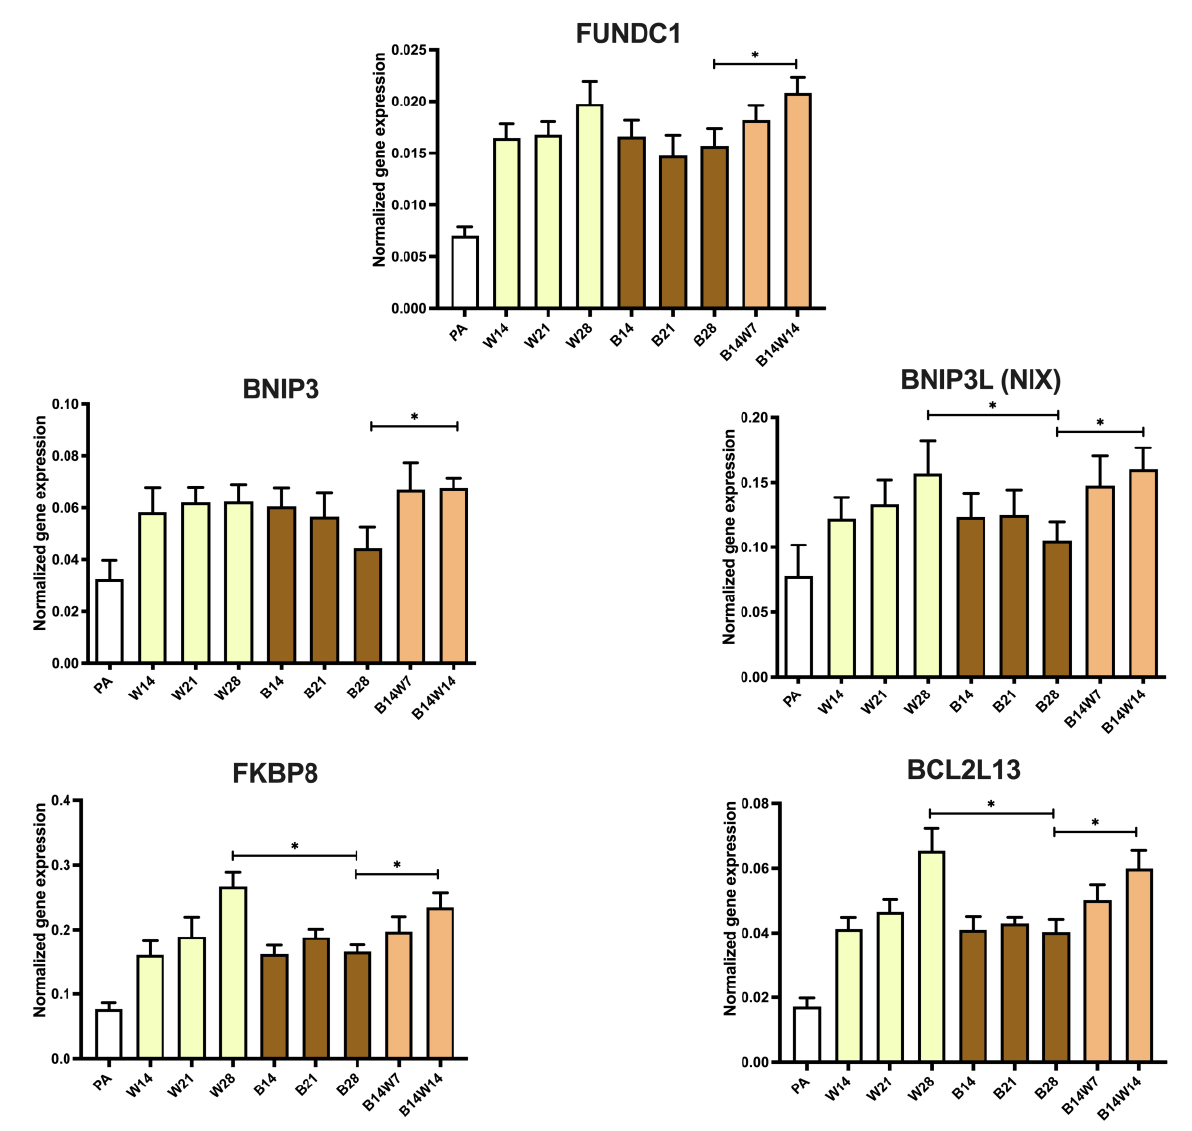
Figure 7. Expression of parkin-independent mitophagy markers in white (W) and beige (B) adipocytes, and in response to transition. Human primary abdominal subcutaneous preadipocytes were differentiated as in Figures 1–6. Quantification of gene expression for FUNDC1 , BNIP3 , BNIP3L , FKBP8 , and BCL2L13 . Gene expressions were normalized to GAPDH . Data are presented as mean ± SD. n = 6. * p < 0.05. We used one-way ANOVA with Tukey’s post hoc test.